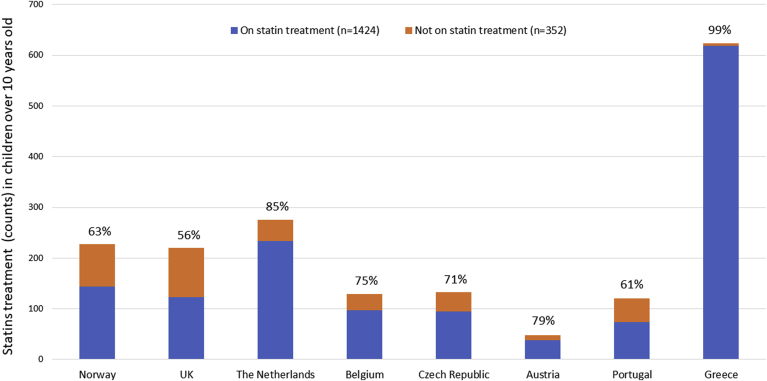
Statin treatment in children older than 10 years of age (at follow-up) per country.Stacked bars represent number of treated and untreated children in each cohort. The percentage on top of each bar shows the proportion of children on statins.